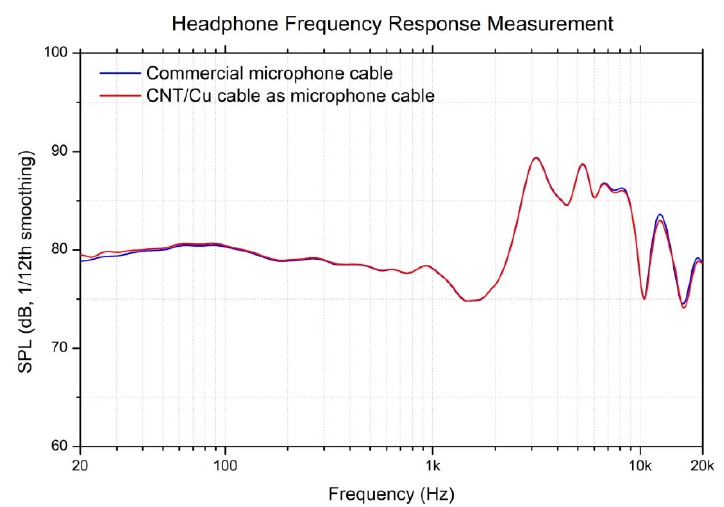
Figure 8. The frequency response of the HiFiMAN Arya headphones (right channel, averaged over three measurements) using a commercial microphone cable compared to the CNT/Cu cable as the replacement microphone cable.